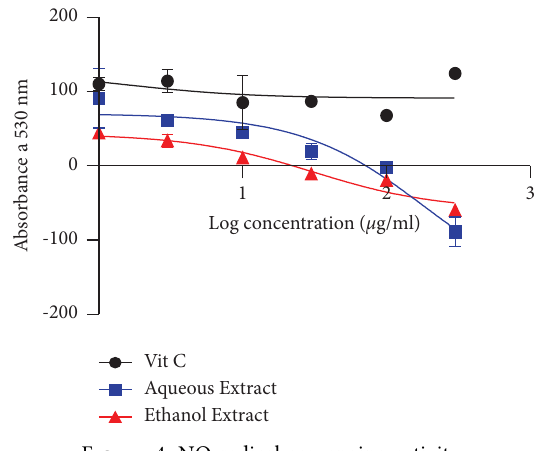
Figure 4: NO radical scavenging activity.